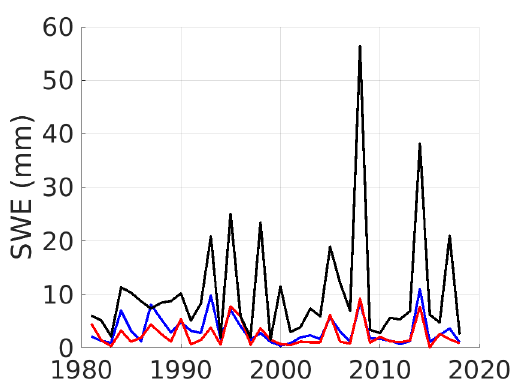
Figure 8. Interannual variation of the annual mean SWE averaged for the High Atlas in differ- ent datasets. Black: ERA5-Land SWE, blue: modeled SWE with ERA5 and red: modeled SWE with